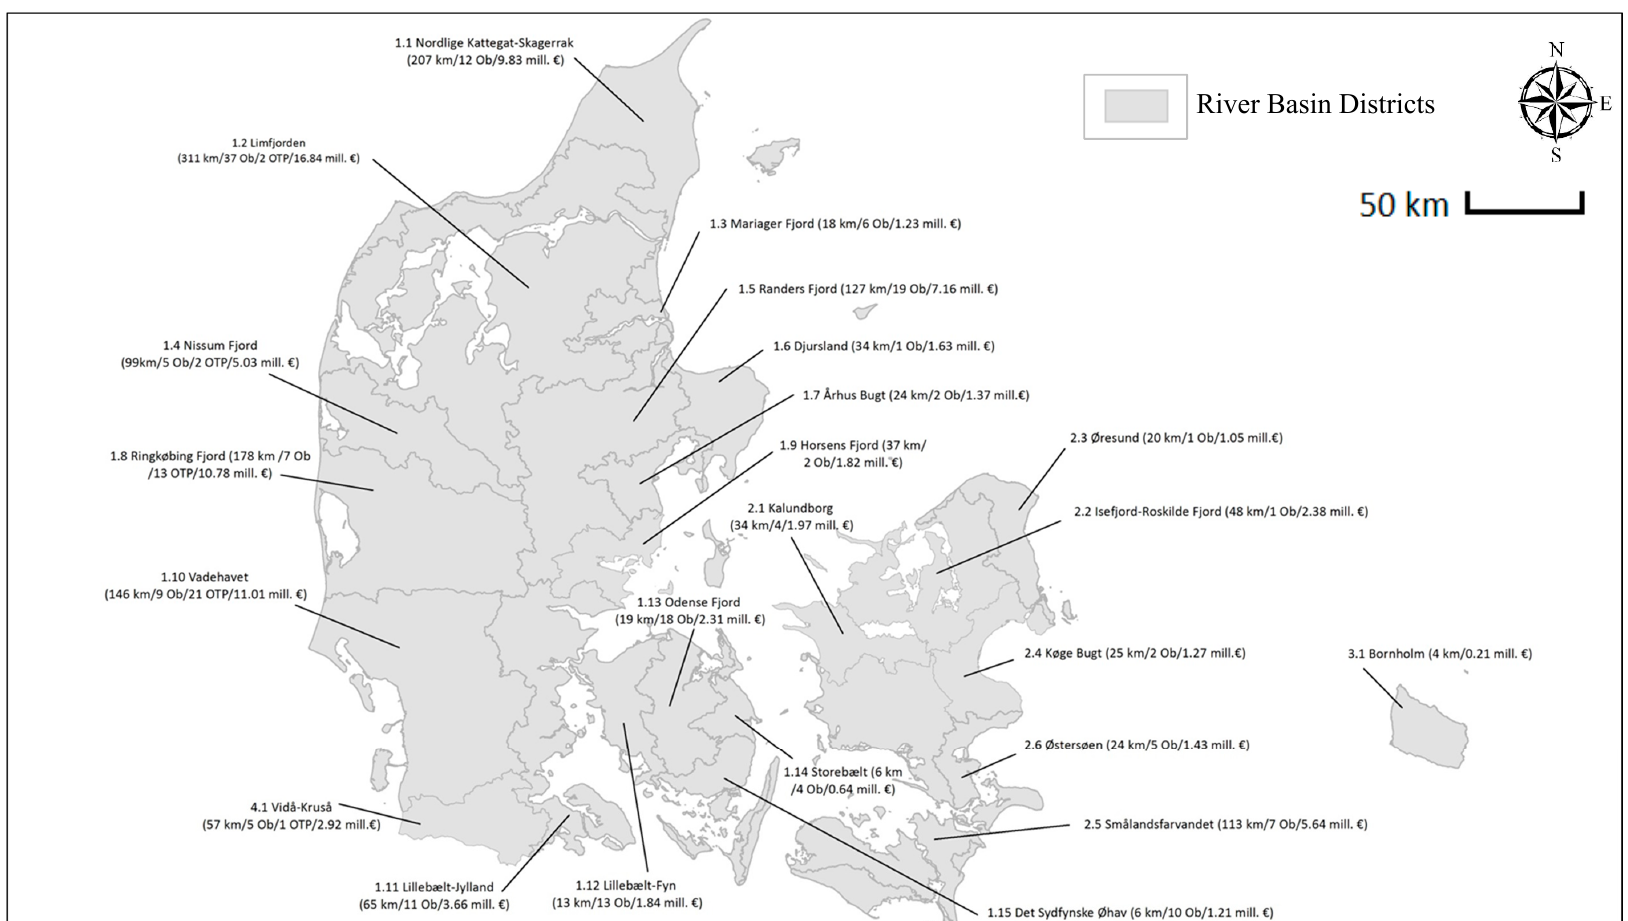
Figure 1. Overview of the 23 River Basin Districts (RBDs) and associated water councils established in 2014 in Denmark, showing the distribution of efforts to be achieved and the economic investment framework for each RBD and water council (for each RBD, the minimum effort is displayed after each RBD in km/number obstacles to be removed/possibly ochre-removal basins to be established/€ million (modified after [66]).